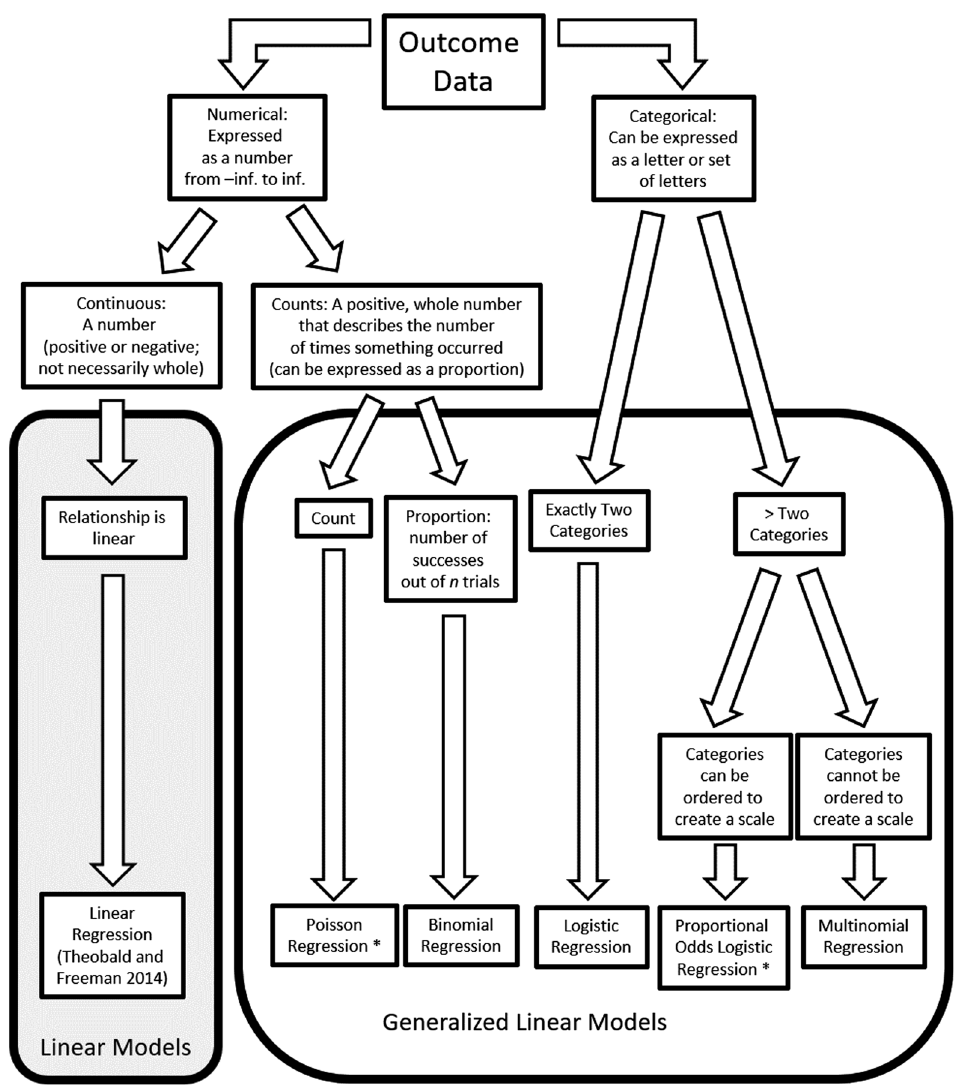
FIG. 1. Diagnostic tool useful for determining which type of generalized linear model is appropriate for the data collected. This tool is used in an analogous manner as a dichotomous key. The * indicates that there are special cases of these models that are discussed in this